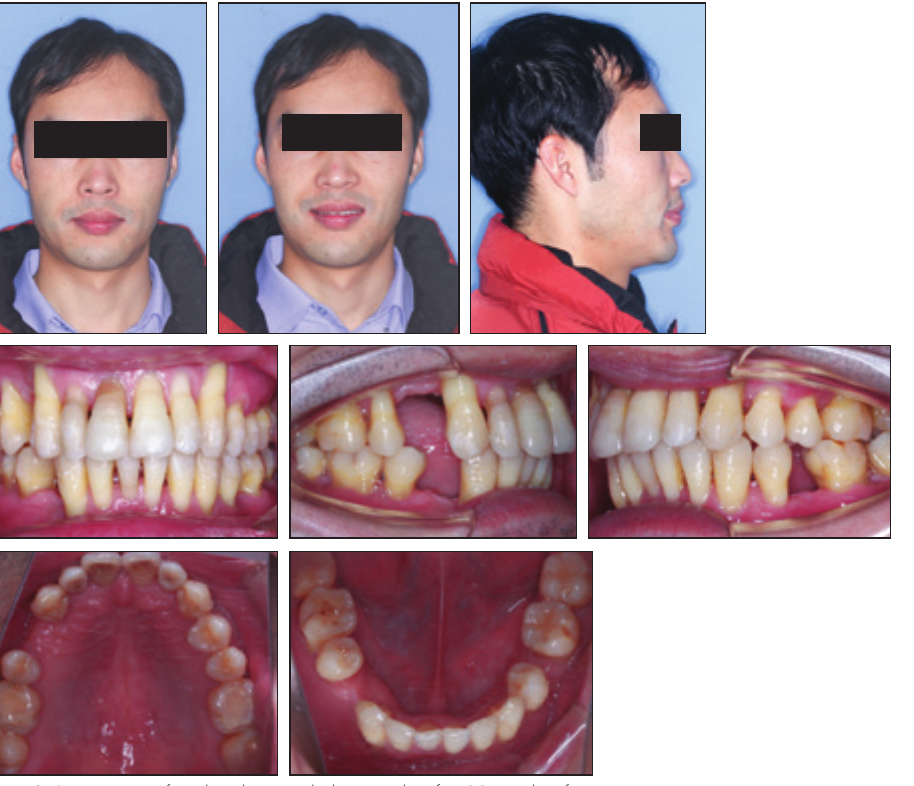
Figure 8. Post-treatment facial and intraoral photographs after 28 months of treatment.